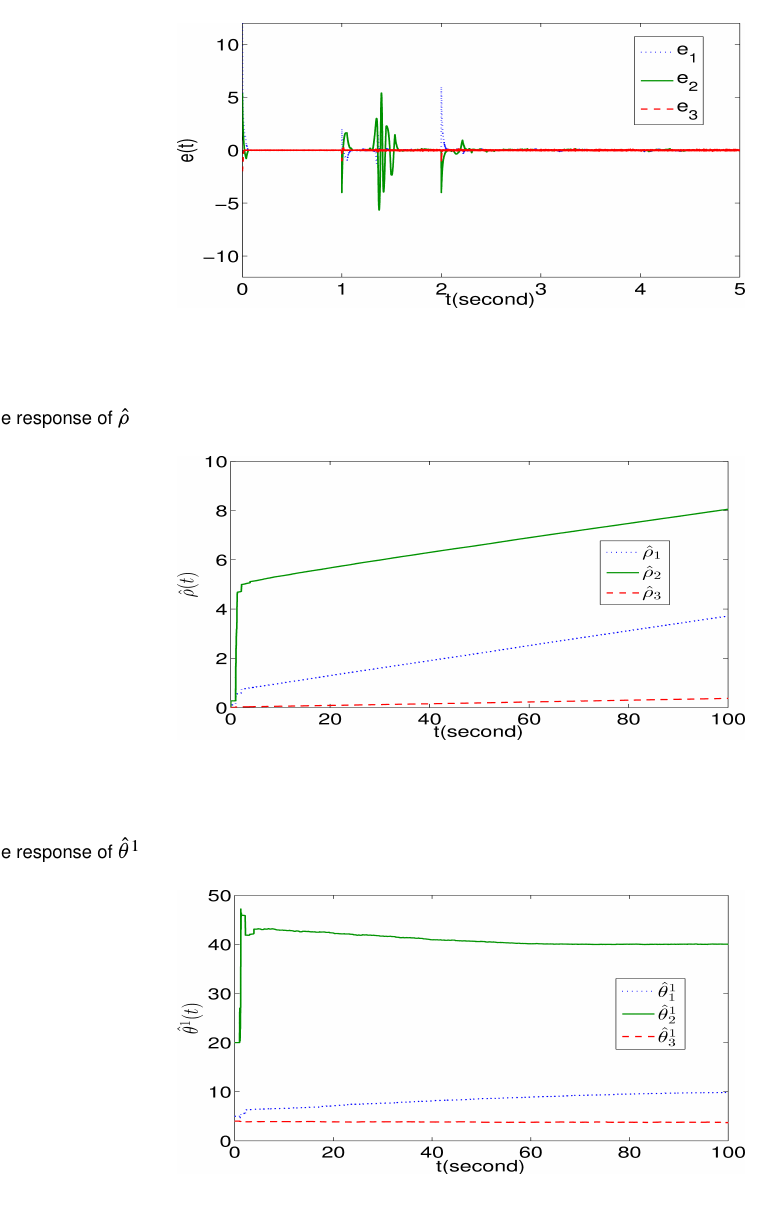
Fig. 1. Time response of MFPLS error e